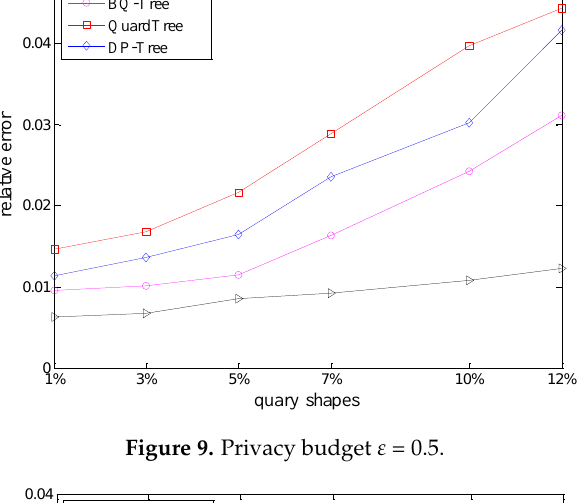
Figure 8. Privacy budget  = 0.1.